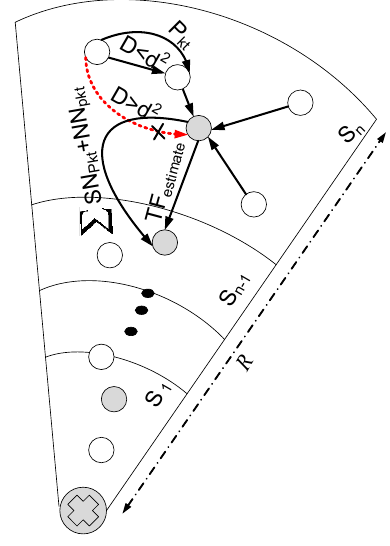
Figure 2. Traffic Load Estimation and Data